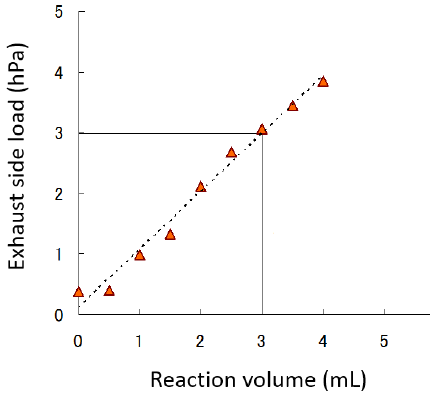
Figure 9. Exhaust-side load with a reaction cell; 3mL of the stan- dard reaction solution is equivalent to a load of approximately